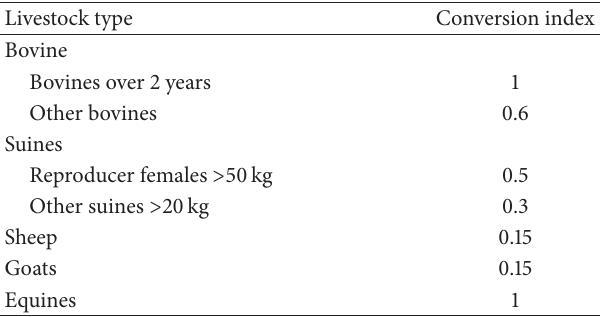
Table 1: The indexes of conversion into normal